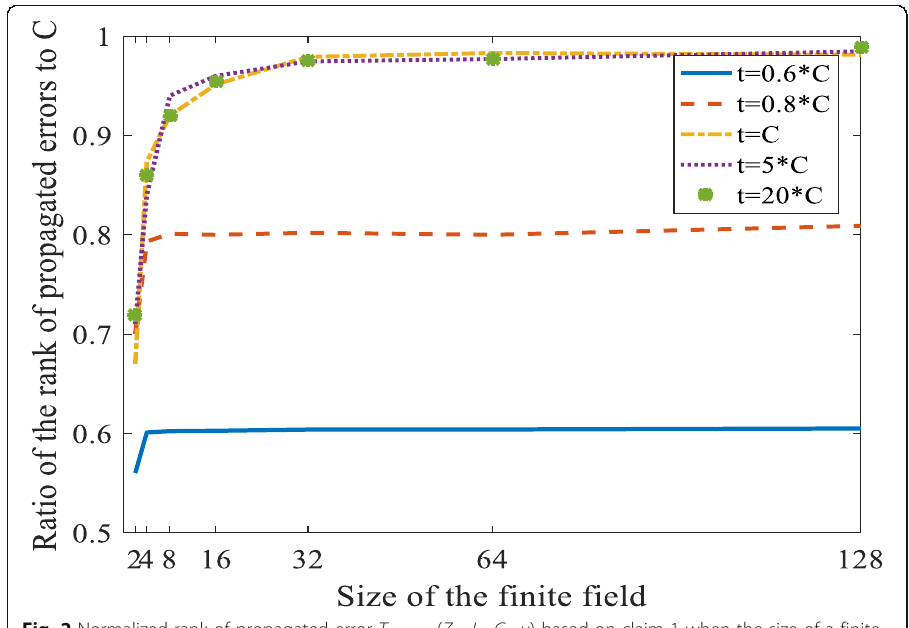
Fig. 2 Normalized rank of propagated error T Z → Y ⋅ ( Z − L ⋅ G ⋅ u ) based on claim 1 when the size of a finite field is even. Legend: The vertical axis value is rank ð T Z → Y (cid:3)ð Z − L (cid:3) G (cid:3) u ÞÞ